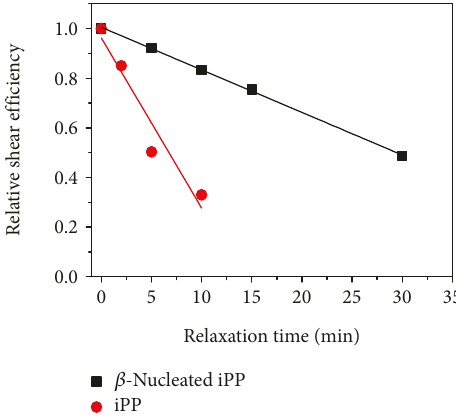
Figure 3: Relative shear e ffi ciency as a function of time for pure iPP and β -nucleated iPP. Flow condition: shear rate = 40 s − 1 , shear time = 10 s , T = 170 ° C , and T = 170 ° C S R